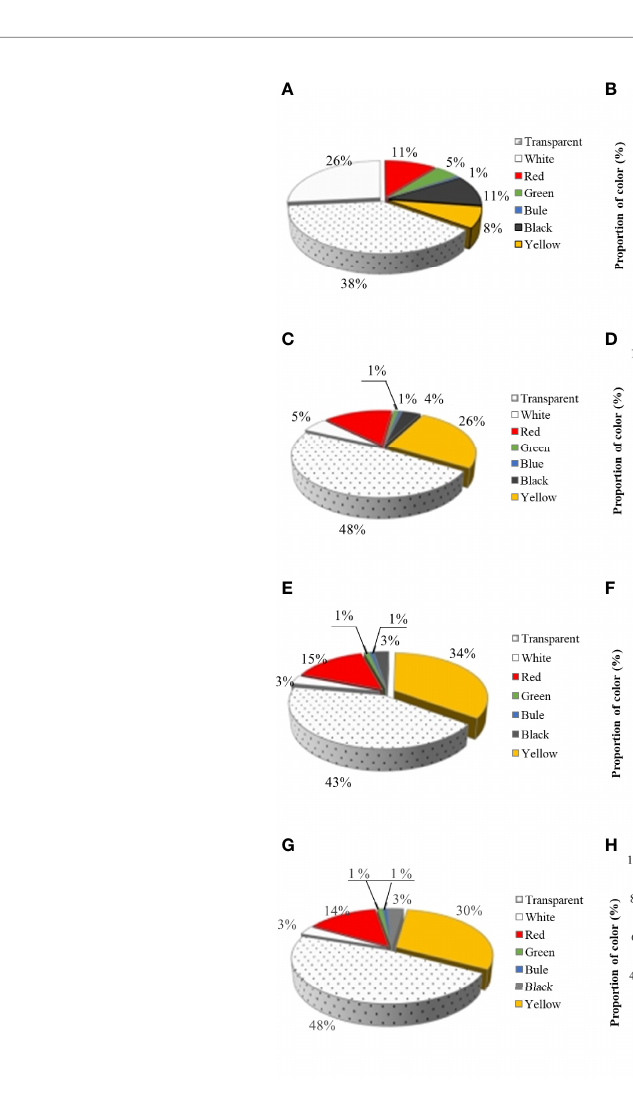
FIGURE 4 | The average abundance of MPs with different colors collected from all zones (A) , and the color distribution from each sampling zone (B) in the seawater. The average abundance of MPs with different colors collected from all zones (C) , and the color distribution from each sampling zone (D) in the sediment. The average abundance of MPs with different colors collected from sand samples collected from BB1 (E) and BB2 (G) , and the color distribution from each sampling site (BB1, F ; BB2, H ). Site Z1 – Z3 and S1 – S4 in the supratidal zone. Site Z4 – Z6 and S5 – S8 in the intertidal zone. Site Z7 – Z9 and S9 – S12 in the subtidal